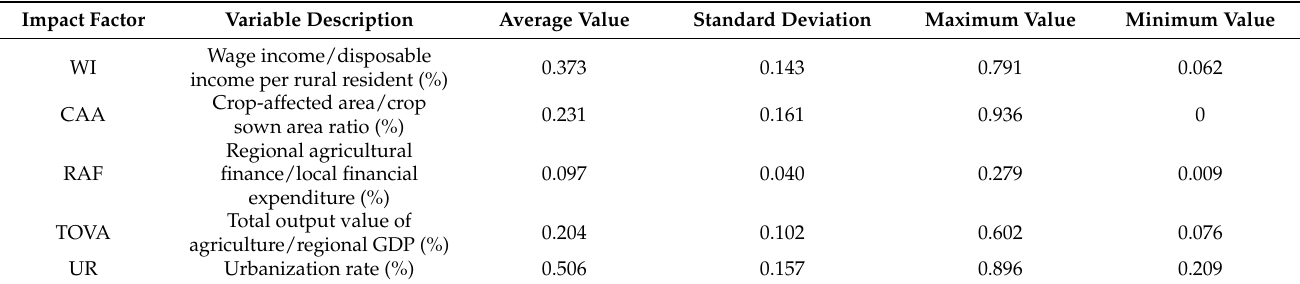
Table 2. Impact factor system and descriptive